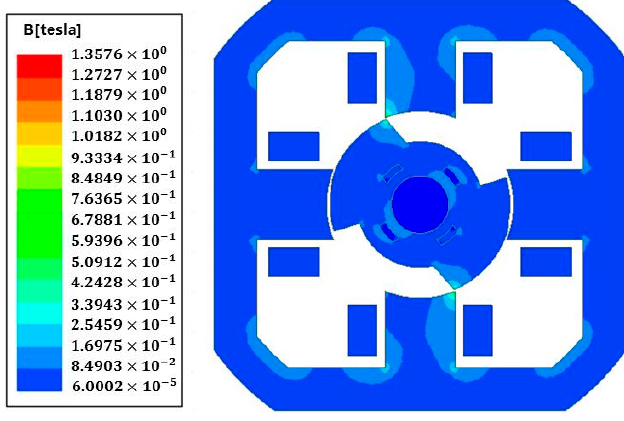
Figure 15. Unaligned position flux density of the designed SRM.